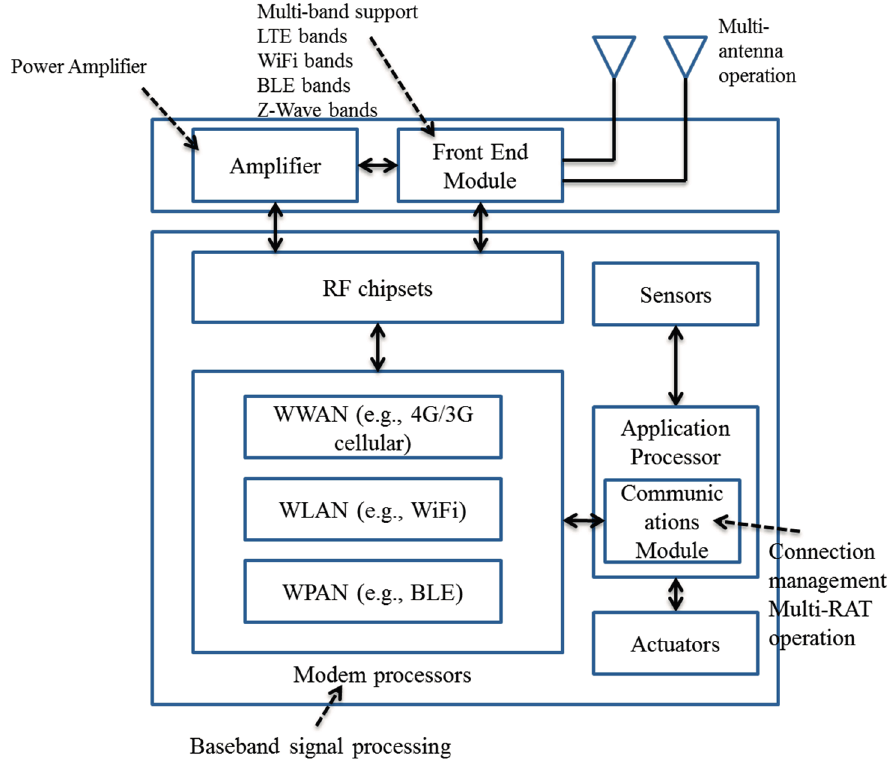
Figure 2. A generic IoT device/gateway structure in which different types of wireless technologies may be